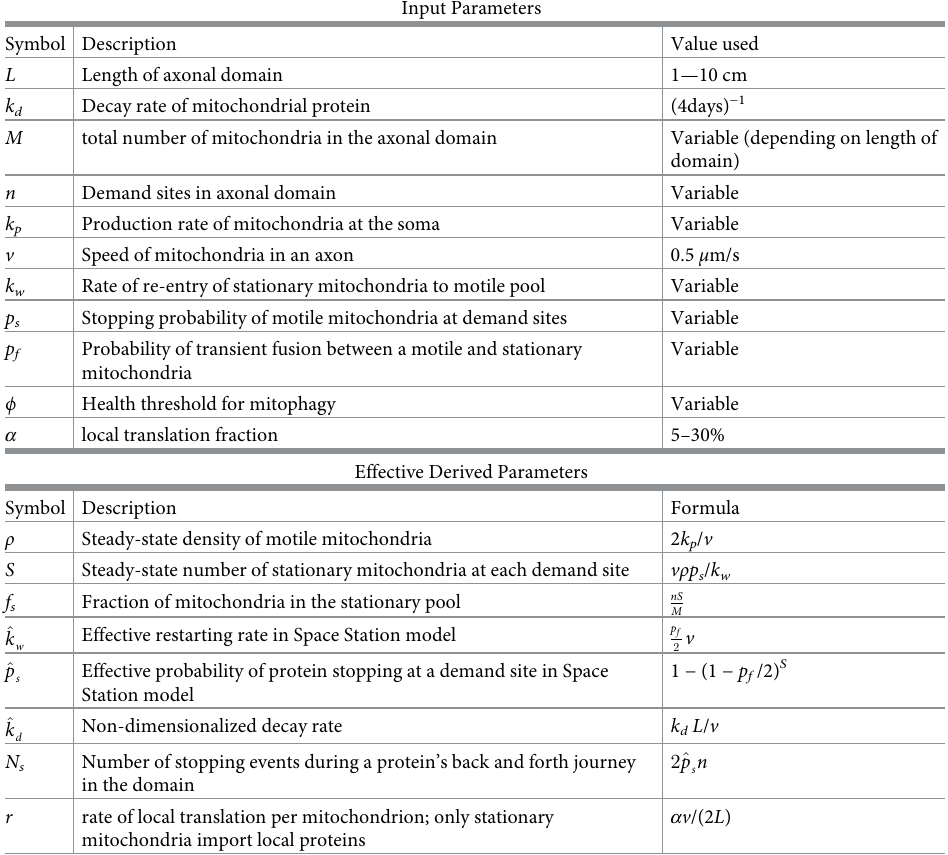
Table 1. Table of model